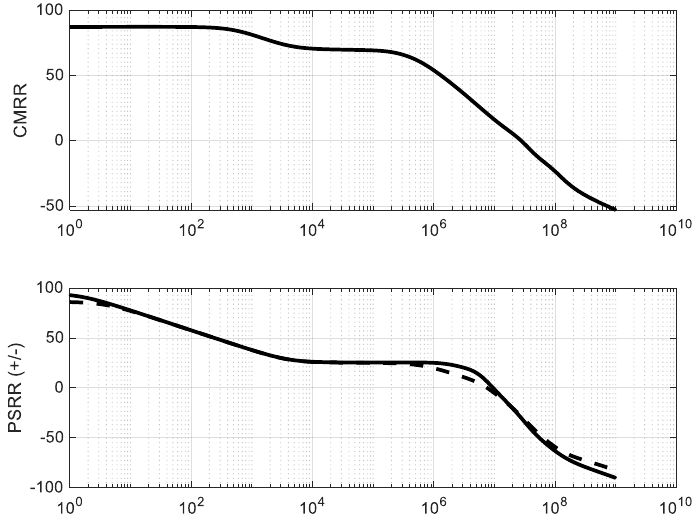
Figure 11. CMRR ( top ) and PSRR ( bottom ) frequency responses. The solid line is the positive PSRR, the dashed line the negative.